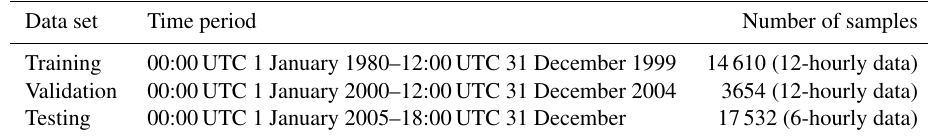
Table 2. Temporal data coverage of training, validation, and testing data for the CNN